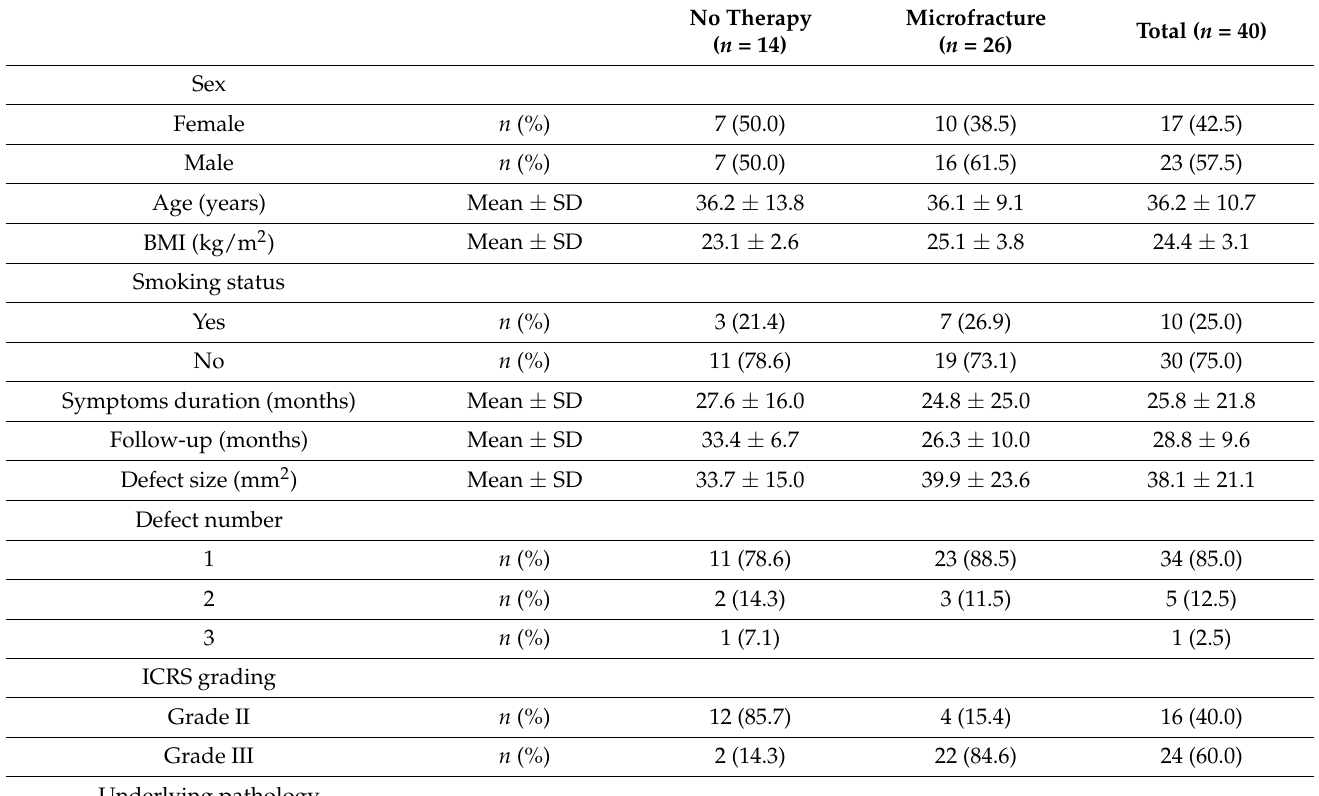
Table 2. Demographic data and baseline characteristics of the study population ( n =